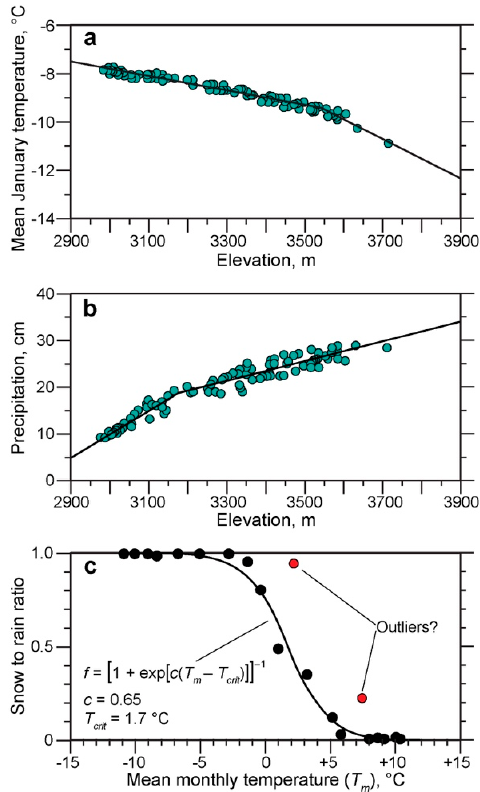
Figure 3. Example of piecewise linear spline fits of ( a ) PRISM mean January temperatures and ( b ) winter precipitation with elevation in the Lake Creek valley. ( c ) Snow to rain ratio as a function of mean monthly temperature based on the available data: two SNOTEL stations, one in and the other immediately outside the study area. The two points that are presumed to be outliers were not used to define the